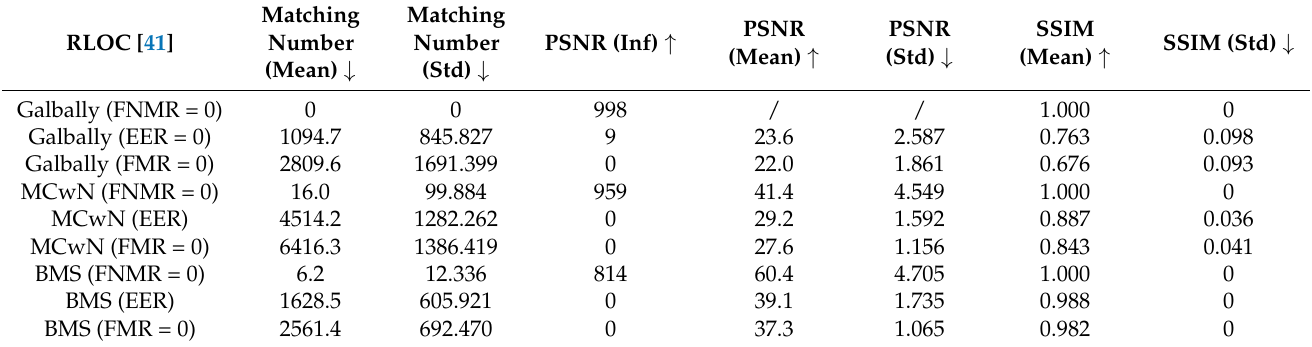
Table 8. Attack performance of RLOC